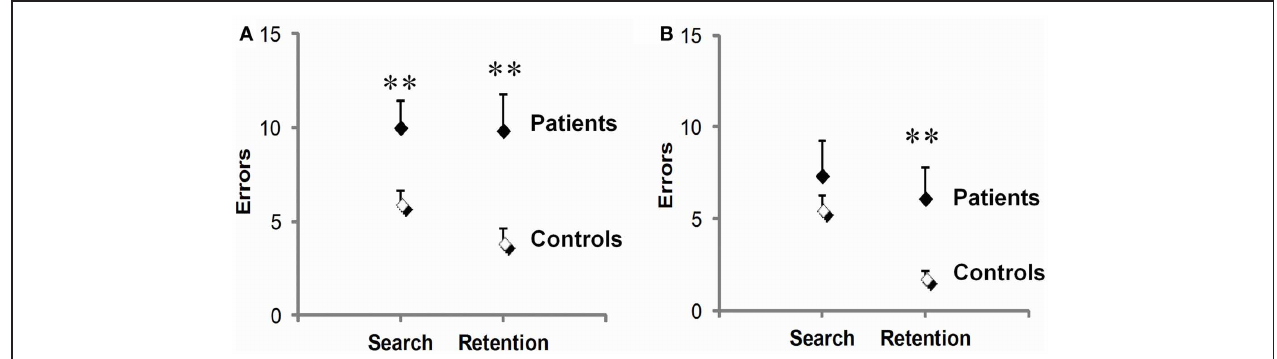
FIGURE 4 | Early (search errors) and late (repetition errors) learning deficits in PD patients relative to controls. Patients were impaired on both measures on test (A) , but not on retest (B) , where only their repetition errors